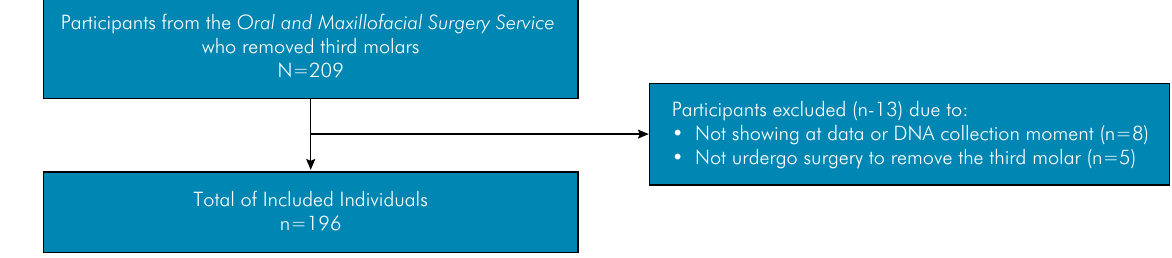
Figure. Flow chart illustrating stages of the study.